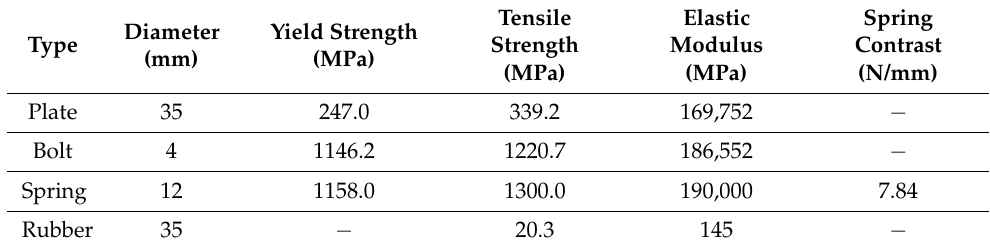
Table 2. Mechanical properties of the materials used in